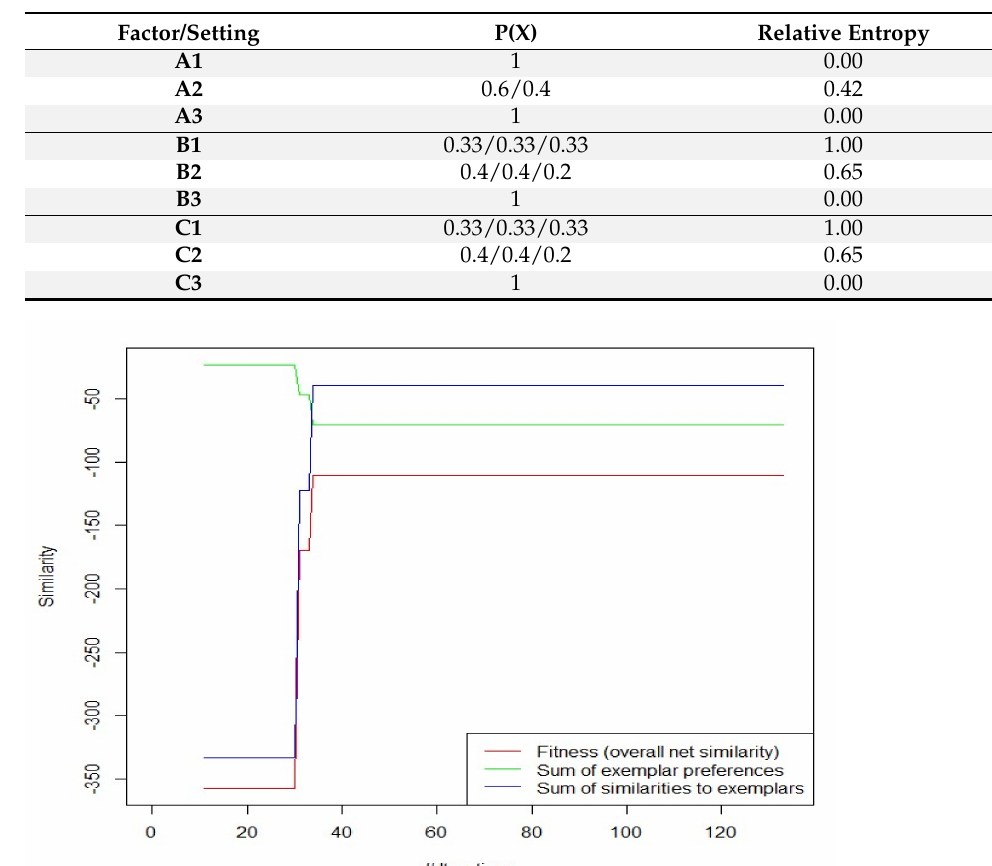
Table 3. Relative entropy for clustered factor settings (confirmation dataset).